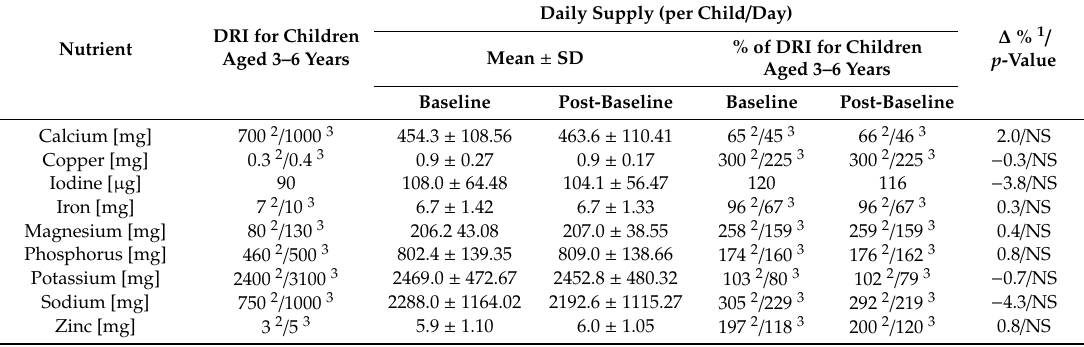
Table 3. The content of minerals (per a child a day) in 231 preschools’ 10-day menus with reference to the age-specific dietary reference intake (DRI) before (baseline) and after (post-baseline) the education